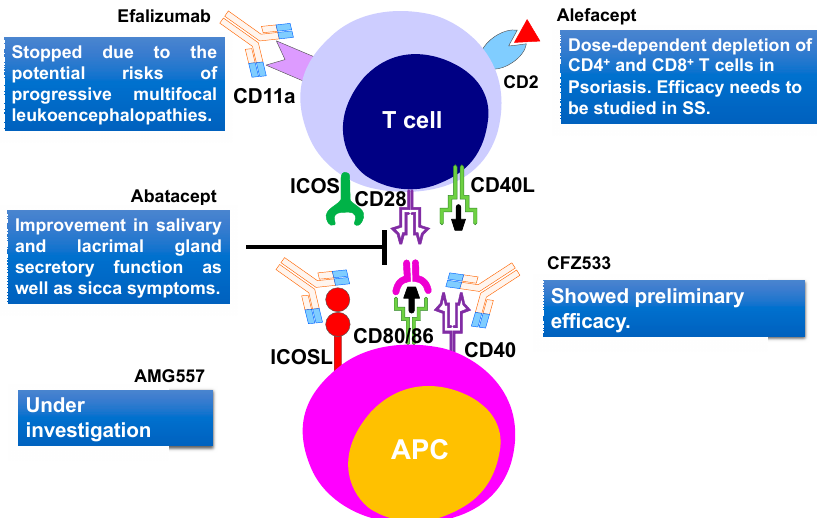
Figure 6. T cell-targeted therapies and their outcomes in primary Sjögren’s Syndrome. Current therapies include CD40, CD80/86, ICOSL, CD11a targeting. CD2, cluster of differentiation 2; CD40, Cluster of differentiation 40; CD28, Cluster of Differentiation 28; CD80, Cluster of differentiation 80; ICOS, inducible costimulatory; ICOSL, ICOS ligand.